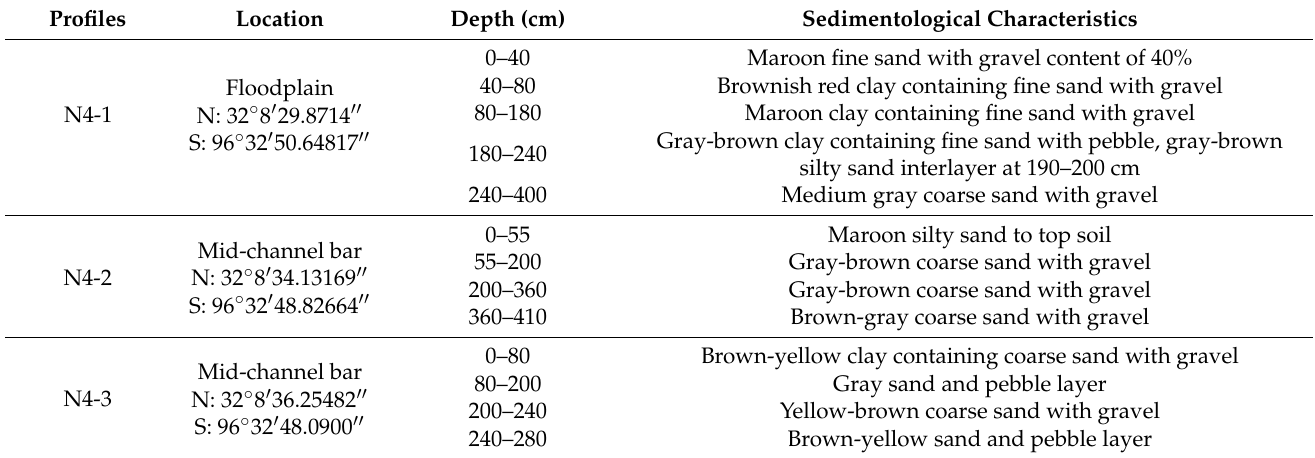
Table 3. Sample information, annual dose rate, and OSL ages: a and b are the number of aliquots measured using SAR and SGC methods, respectively.